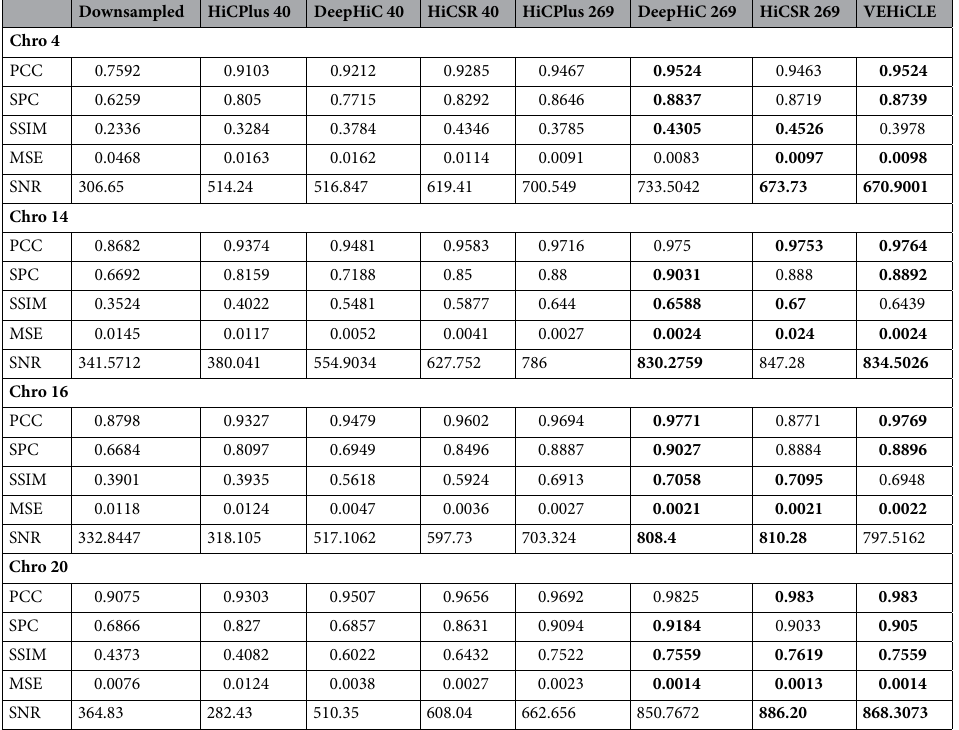
Table 1. Comparison of multiple standard vision metrics across different super-resolution algorithms. Networks are trained using the training set chromosomes of the GM12878 cell line and evaluated on the test chromosome set of the GM12878 cell line. Top 2 scores for each metric are